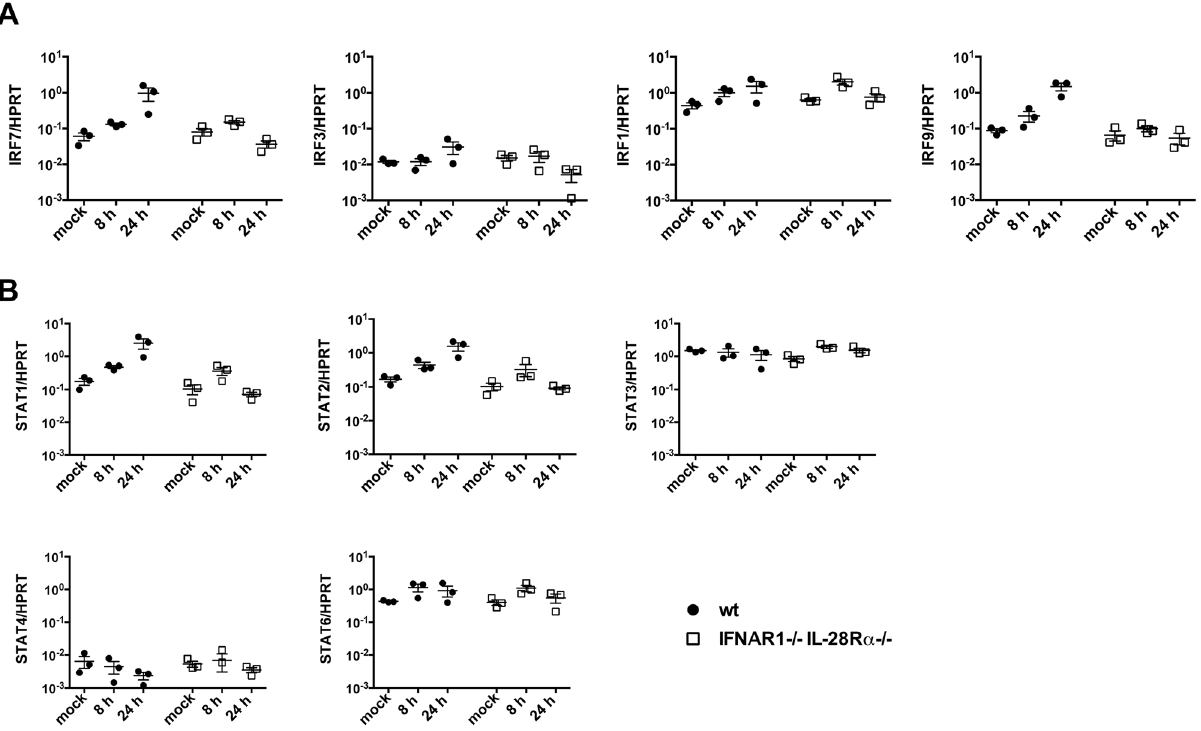
Figure 7. Basal expression of signalling intermediates is similar in wild-type and IFNAR1 2 / 2 IL-28R a 2 / 2 double knock-out MTEC. (A) Relative expression of IRF3, IRF1, IRF7 and IRF9 was determined in both mock infected and PR8 infected MTEC by qRT-PCR. The transcripts quantities are expressed as ratio to HPRT levels + / 2 SEM. (B) The same RNA samples were analyzed for STAT1, STAT2, STAT3, STAT4 and STAT6 expression.